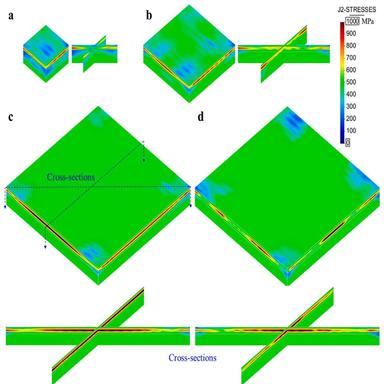
Residual von Mises stresses of different MMS parts: (a) Case-1; (b) Case-2; (c) Case-3; (d) Case-4.